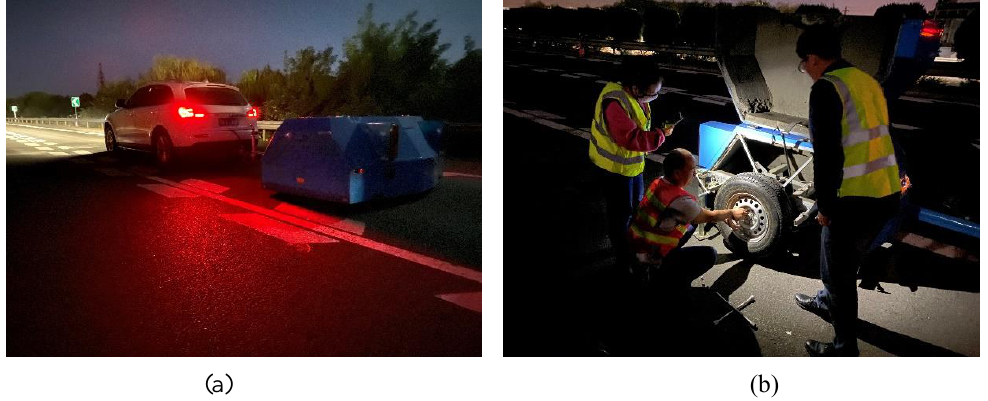
Figure 2. On-site testing: ( a ) a CPX trailer; ( b ) the test tire Figure 2: On-site testing: (a)a CPX trailer; (b)the test tire replacement.